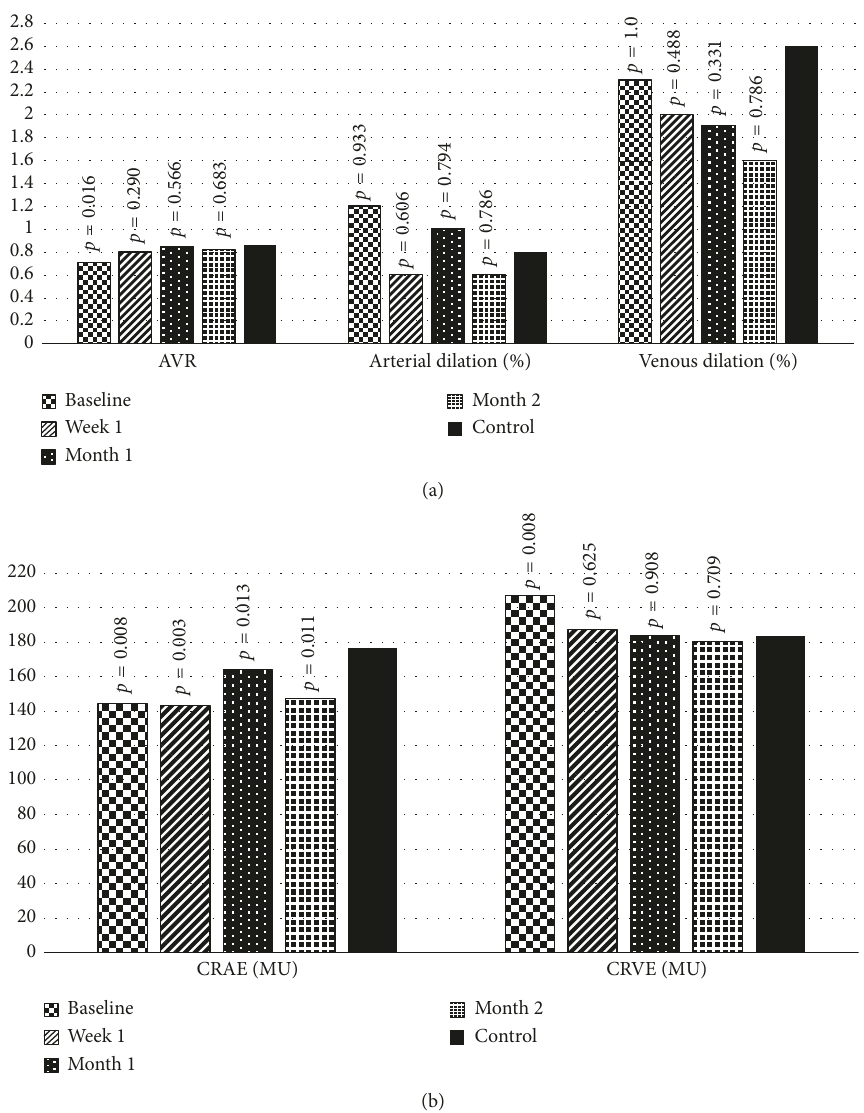
Figure 3: Comparisons of different static (a, b) and dynamic analysis (a) parameters in patients with macular edema secondary to retinal vein occlusion, at baseline (before injection) and 1week, 1month, and 2months after injection. AVR retinal artery equivalent; CRVE deviation and median (25–75